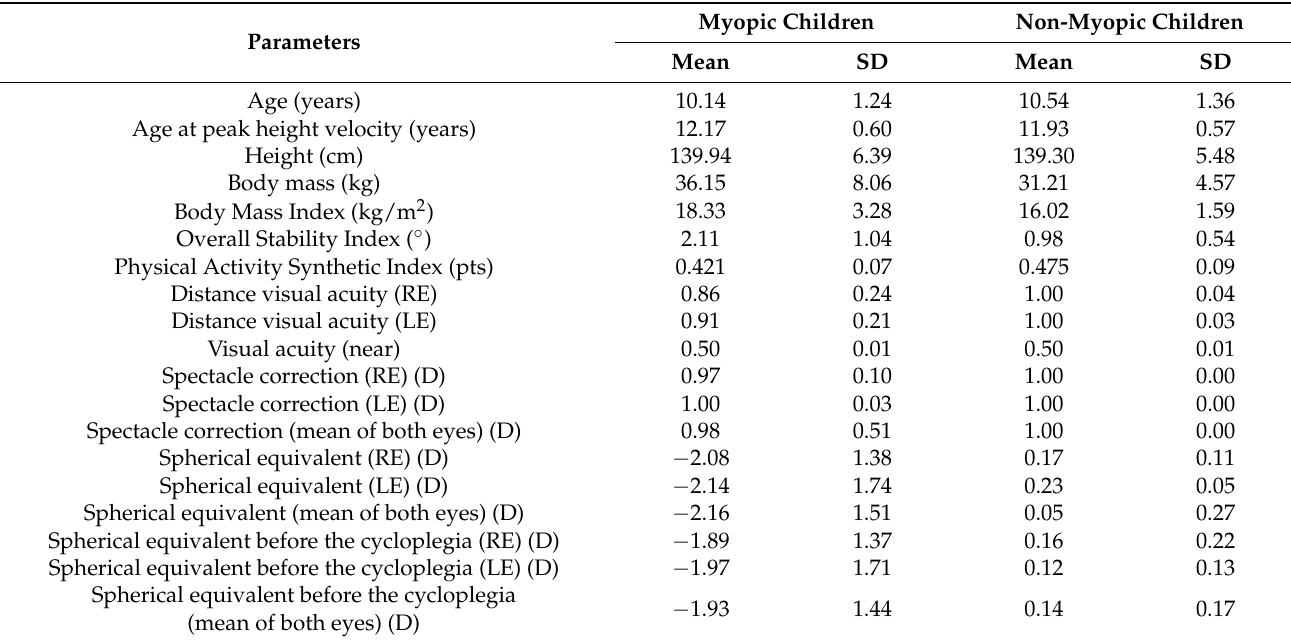
Table 1. Demographic and clinical characteristics of the